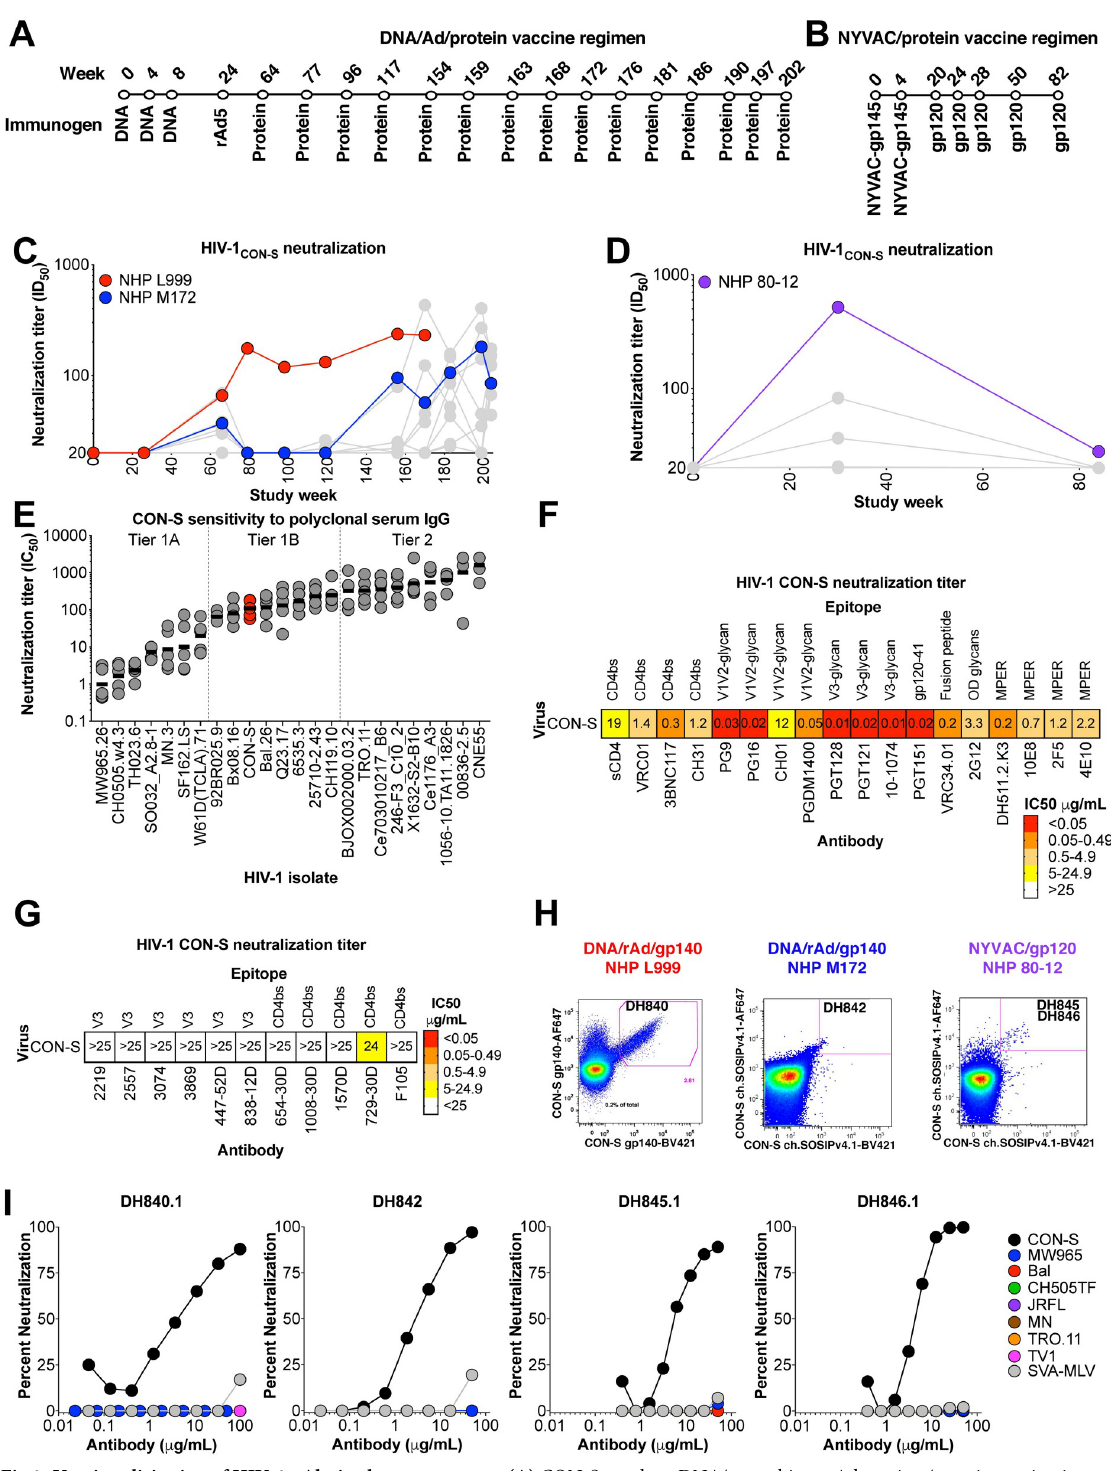
Fig 1. Vaccine elicitation of HIV-1 nAbs in rhesus macaques. (A) CON-S envelope DNA/recombinant Adenovirus/protein vaccination regimen administered to macaques L999 and M172 (see Materials and methods for details). ( B) Macaque 80–12 was immunized with a NYVAC vector expressing gp120 followed by boosting immunization with recombinant gp120. ( C,D) Macaque serum neutralization of HIV-1 CON-S infection of TZM-bl cells. Serum or plasma was obtained two weeks after immunization and examined for neutralization. Neutralization titer is shown as reciprocal plasma or serum dilution that inhibits 50% of virus replication (ID 50 ). Macaques from which